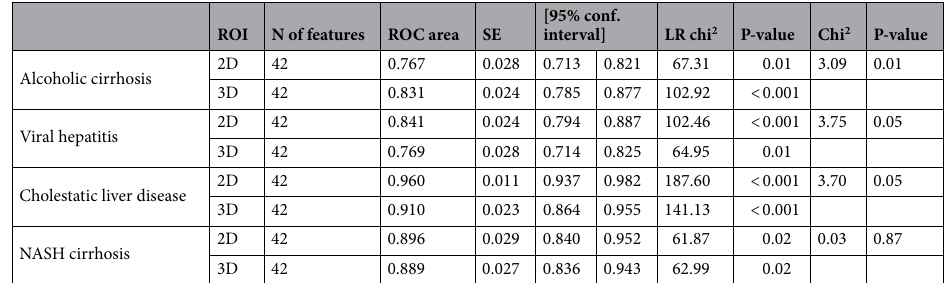
Table 3. Logistic regression analysis of the testing subset for alcoholic cirrhosis, viral hepatitis-induced cirrhosis, cholestatic liver disease-induced cirrhosis, and NASH-associated cirrhosis. NASH nonalcoholic steatohepatitis.